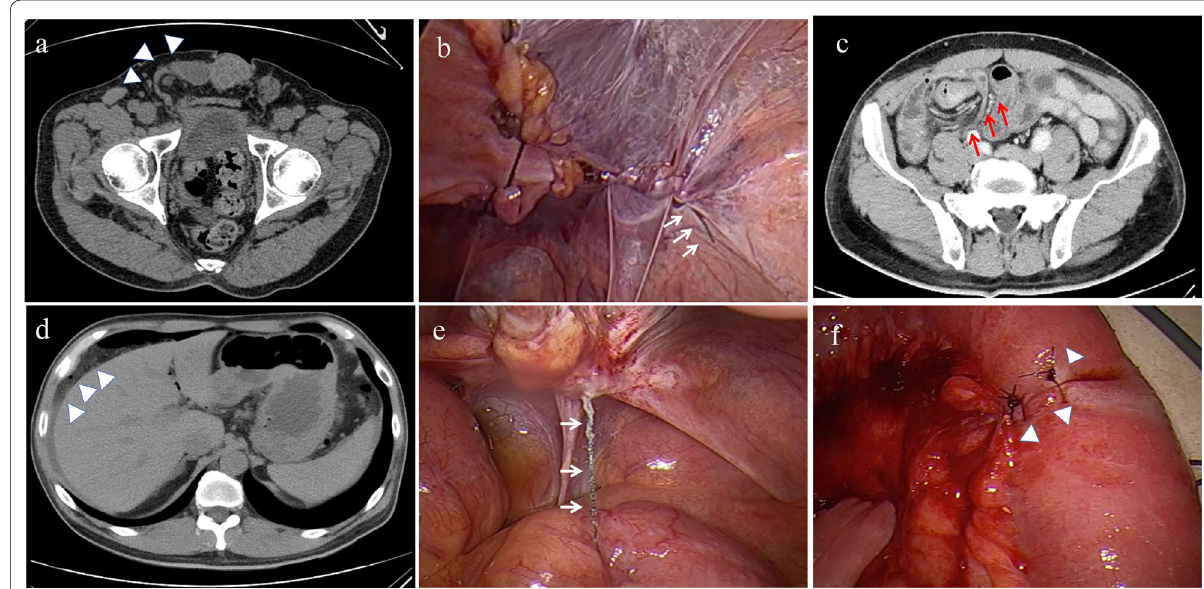
Fig. 2 Preoperative and intraoperative images in Case 2. a The CT shows a right direct inguinal hernia in the prone position (white arrowheads). b The self-anchoring barbed suture device is used to close the right inguinal peritoneal defect from the left side to the right. The residual tail is less than 1 cm (white arrows). c The patient was readmitted with unremitting abdominal pain on postoperative day 10. There is obvious edema of small intestine, possibly volvulus of the ileum (red arrows). d Free air and ascites in the abdominal cavity, indicating perforation of the small intestine (white arrowheads). e The tail of the barbed suture is much longer and has inserted into the small intestine (white arrows). f After release of redundant barbed suture and removal of the tail of the barbed suture the perforated small intestine is closed with 2 stitches (white